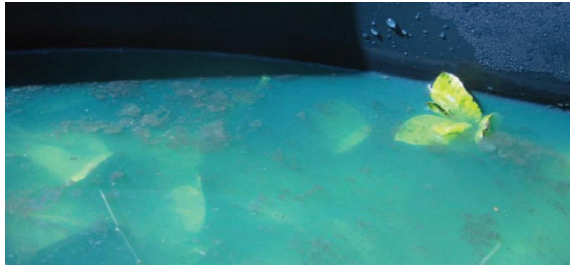
Figure 3: Te colour of extraction water when fermentation is nearing completion (photo by Kori Hargreaves)